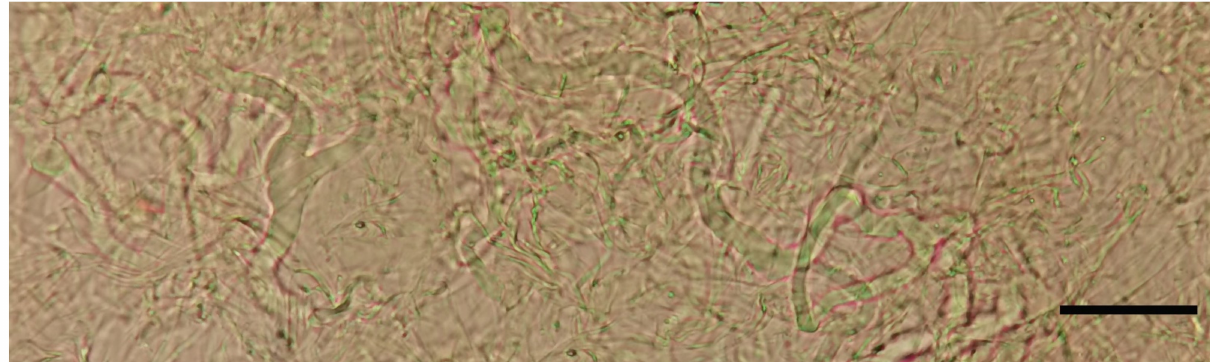
Figure 6. Laticifers of Asproinocybe sinensis, from HMJAU59025 (Holotype), in pure water. Scale bar = 20 µ m.